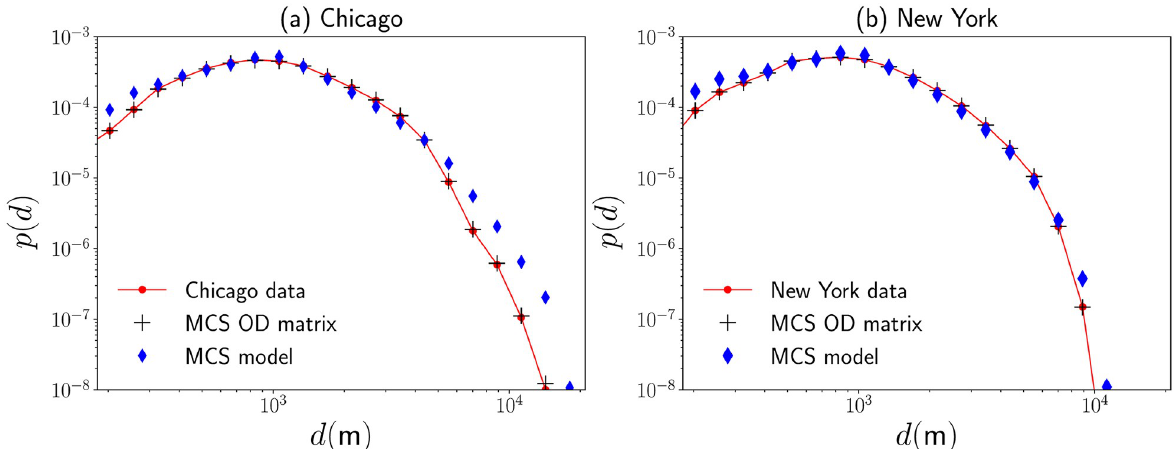
Fig 6. Statistical analysis of displacements in bicycle-sharing systems. We depict the probability density p ( d ) of the geographical distance d between initial and final stations of BSS users in the cities of (a) Chicago and (b) New York. We present statistics obtained from the analysis of the complete datasets and random transitions between the departure station i and the final location j . Simulated values are generated by using Monte Carlo simulations (MCS) with transition probabilities o ð OD Þ calculated with information in the OD matrix and the transition probabilities o ð a Þ i ! j defined by the model in Eqs (16) and (17). Continuous lines presented with the analysis of the datasets with real registers of the mobility are used as a guide.